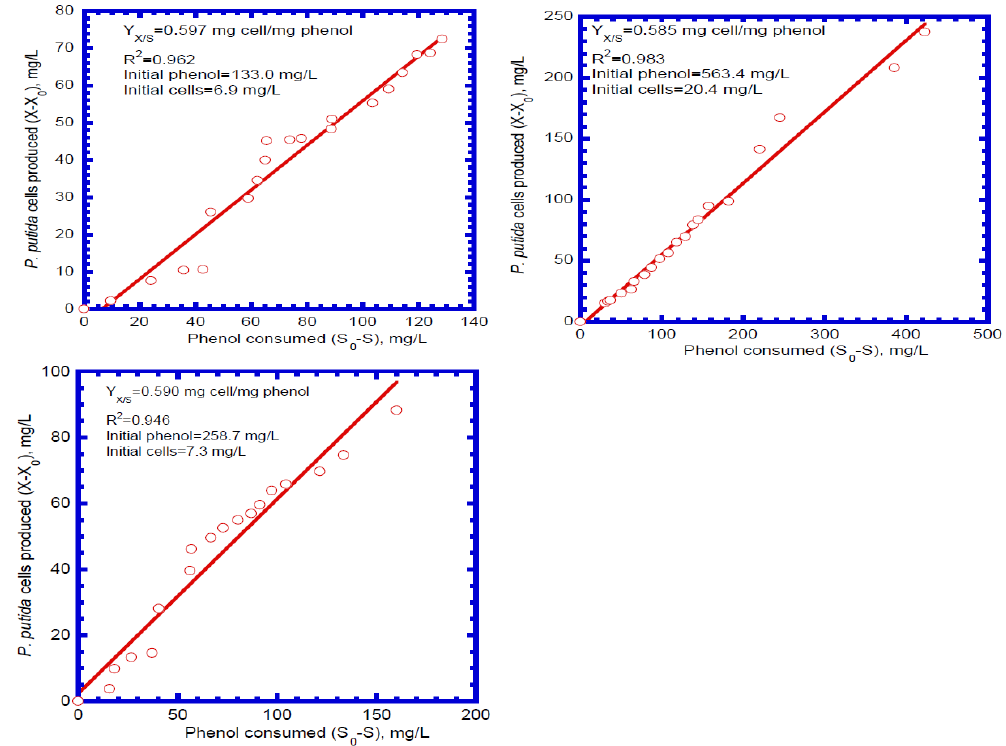
Figure 9. Plot to calculate the yield coefficient (Y) for P. putida cells at various initial phenol and cell concentrations.